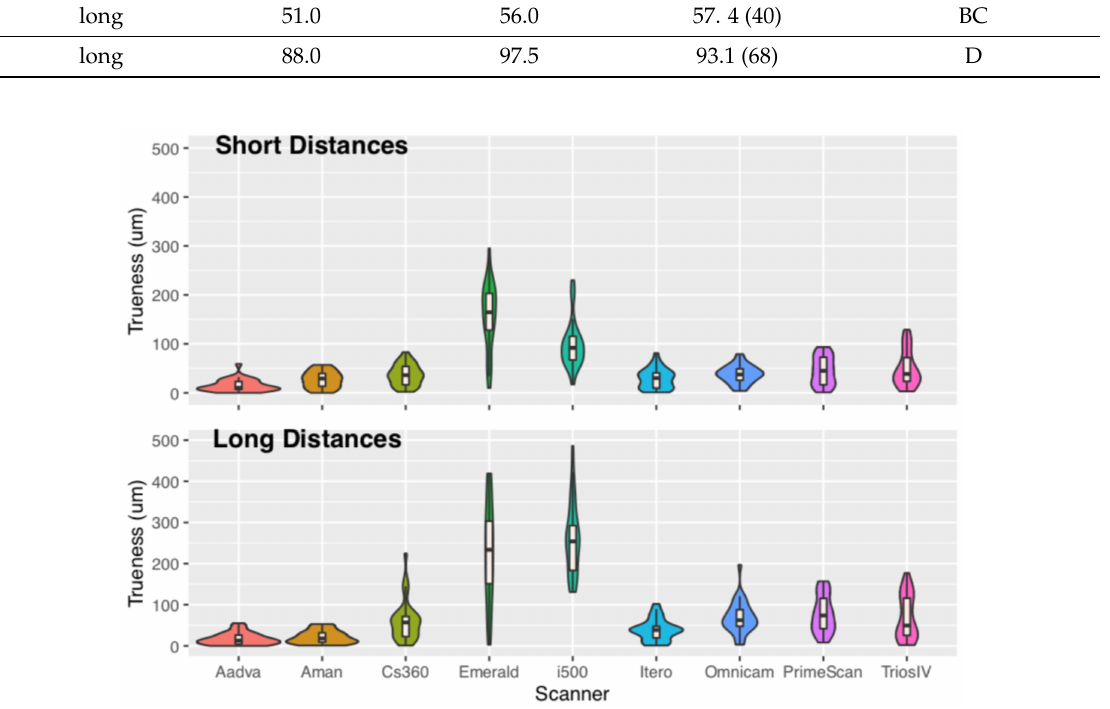
Figure 3. Linear distance mean error and comparison between different digital scanners for trueness.